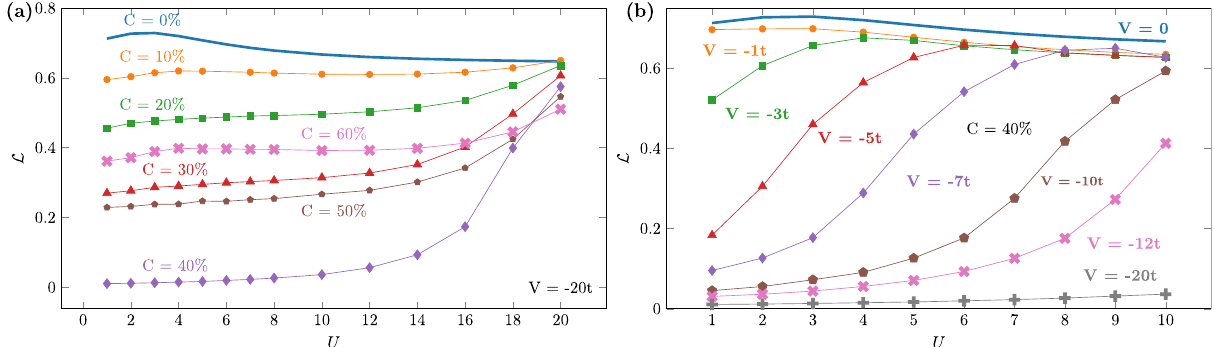
Figure 1. Entanglement of disordered nanostructures as a function of the particle interaction: ( a ) for several concentrations C of impurities with strength V = − 20 t and ( b ) for several disorder strengths V at the critical concentration C C = 100 n / 2 = 40%